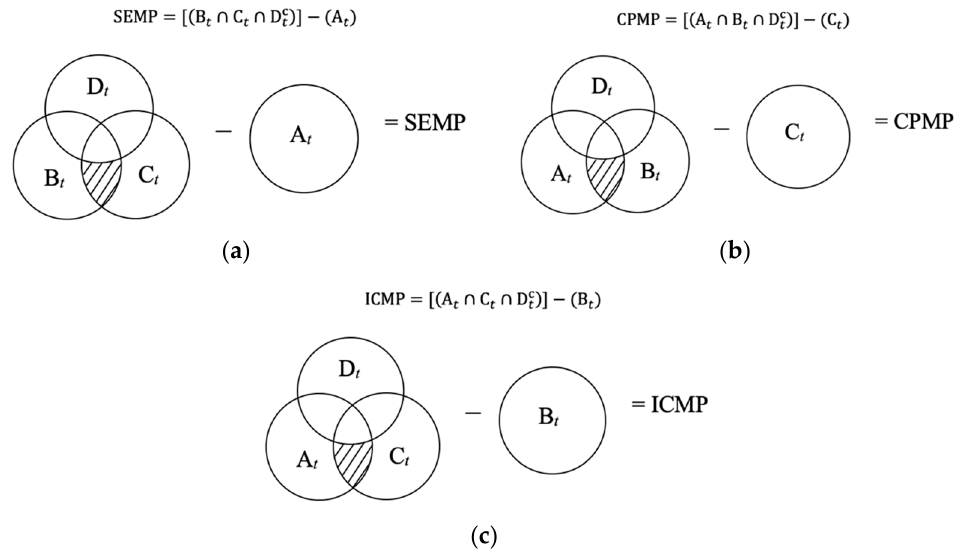
Figure 2. Venn diagram visualization of ( a ) side effect of MP (SEMP), ( b ) competence of MP (CPMP), and ( c ) incapability of MP (ICMP) gene classes.